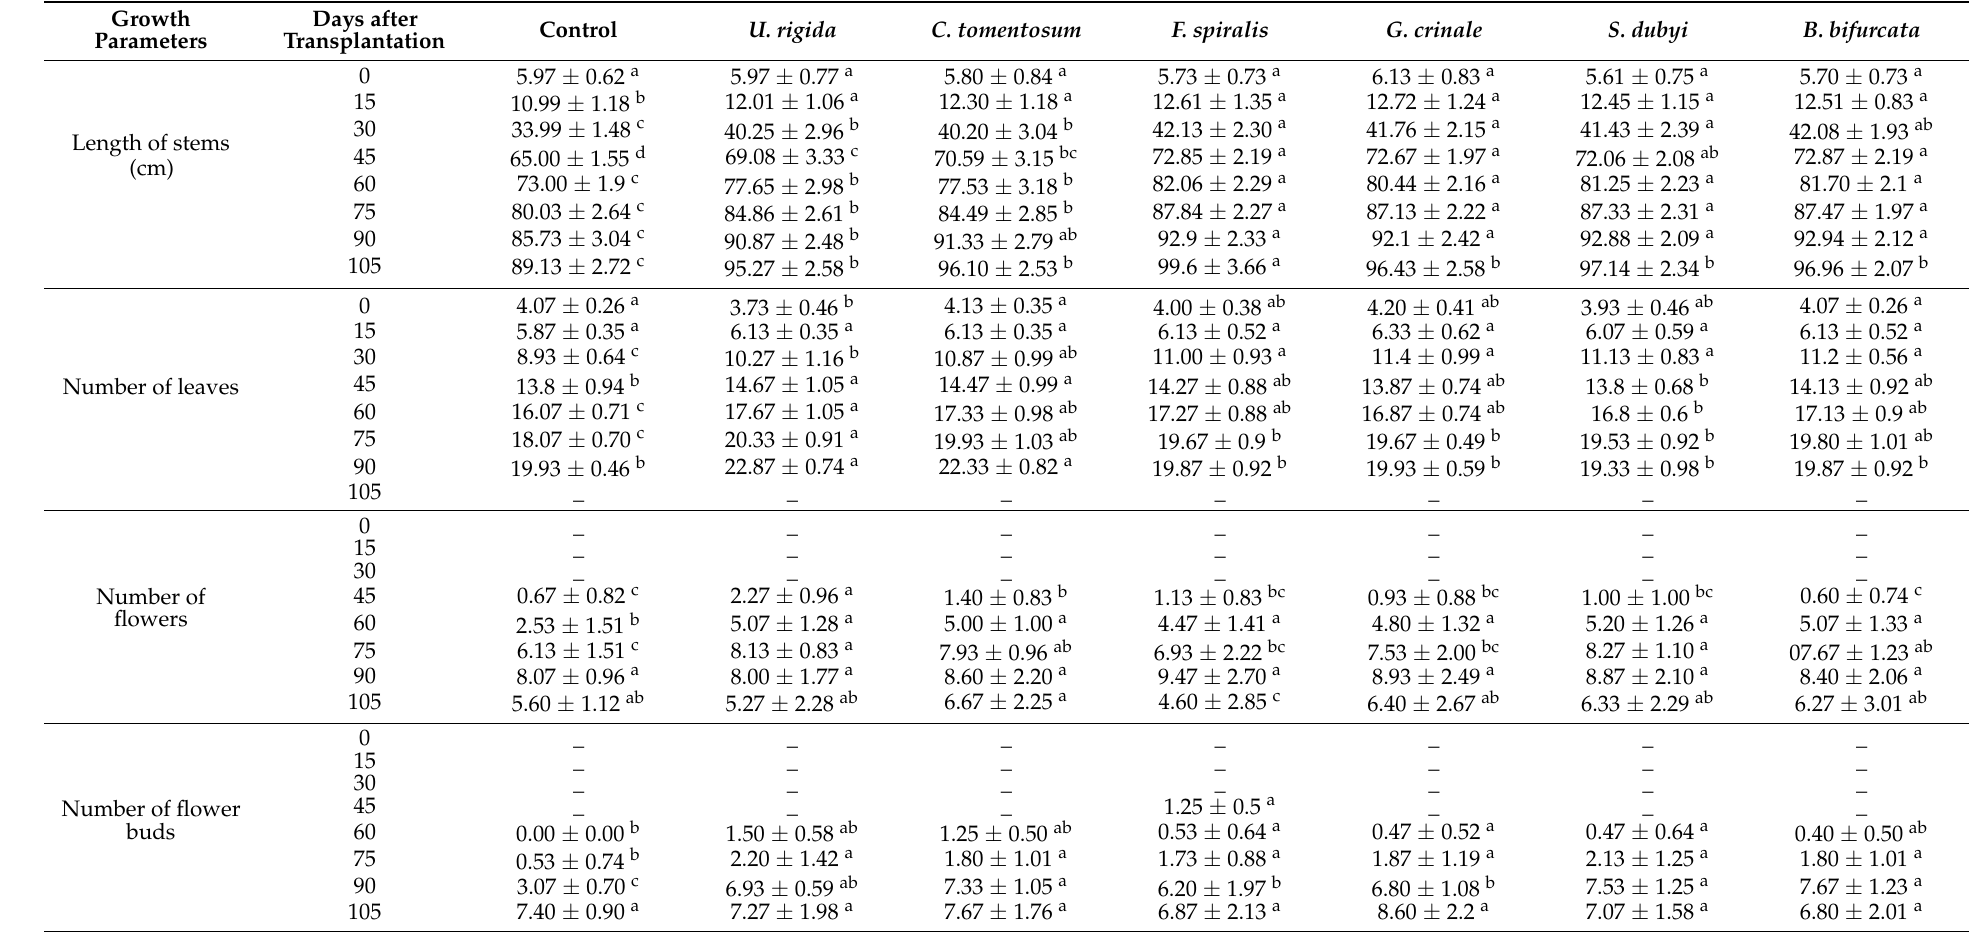
Table 4. Growth parameters (plant length, number of leaves, number of flowers, and number of flowers buds) of tomato plants treated 4 times (1 application after transplantation, 2 applications during the vegetative phase of growth, and 1 last application during the reproduction phase) with PEEs treatments obtained from Moroccan seaweeds or Distilled water (control plants). The data represent the mean values of 15 repetitions ± standard deviations. Different letters represent significant statistical values at ( p ≤